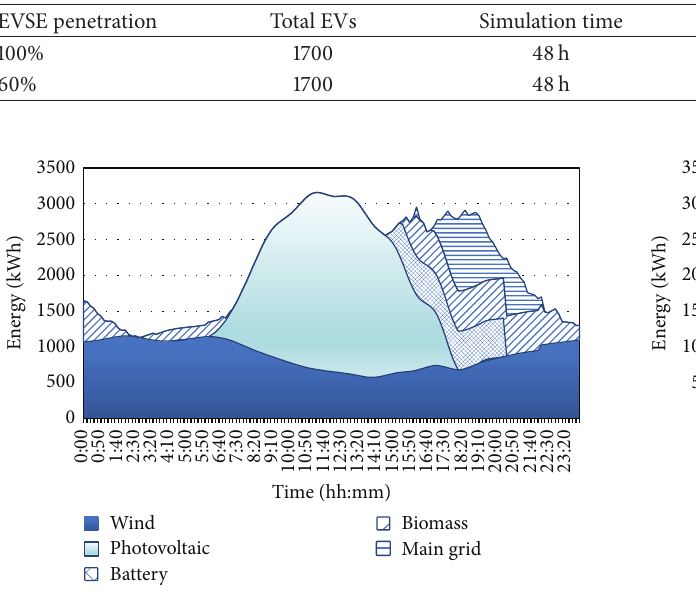
Figure 12: HRES energy supply with 60% EVSE penetration.